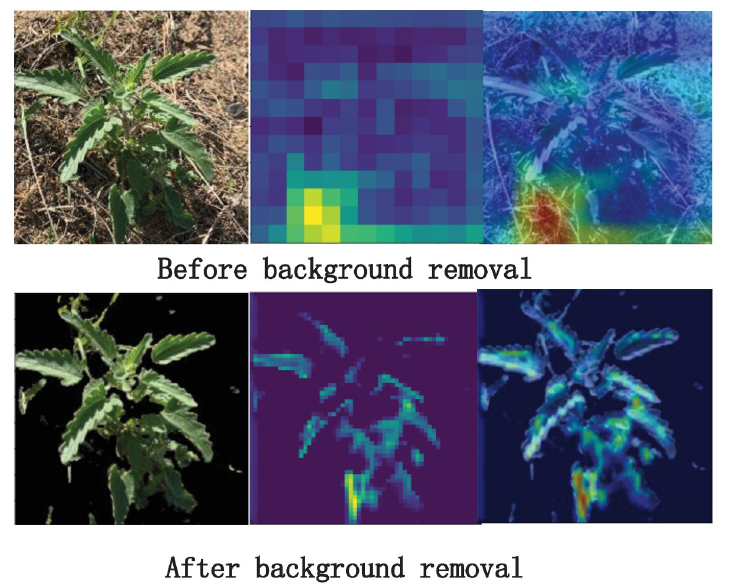
Fig 8. Comparison of active thermograms before and after background